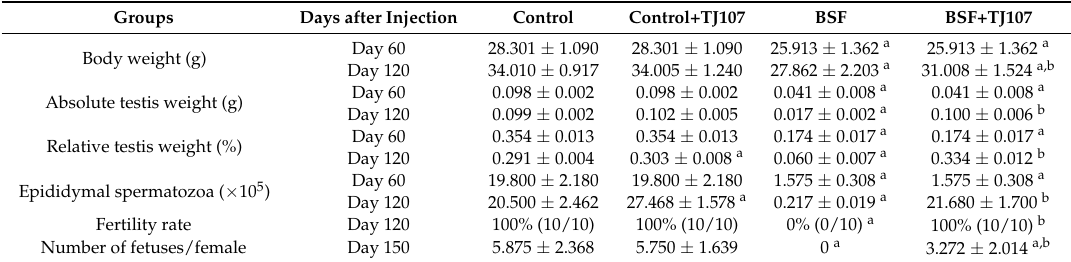
Table 1. Testicular weights and epididymal spermatozoa numbers in the study groups.